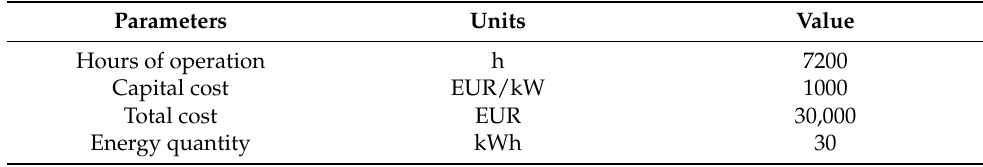
Table 7. Initial assumptions for the PSA